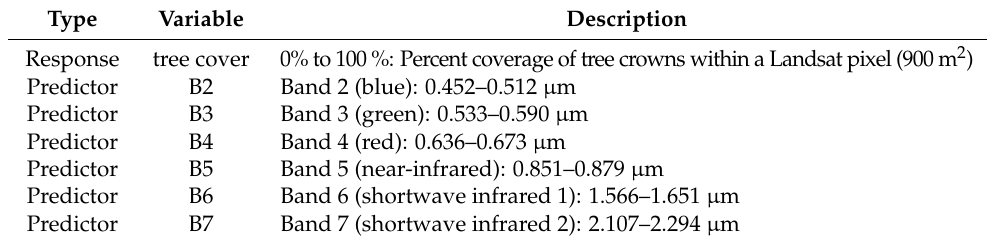
Table 2. List of variables used for the training data